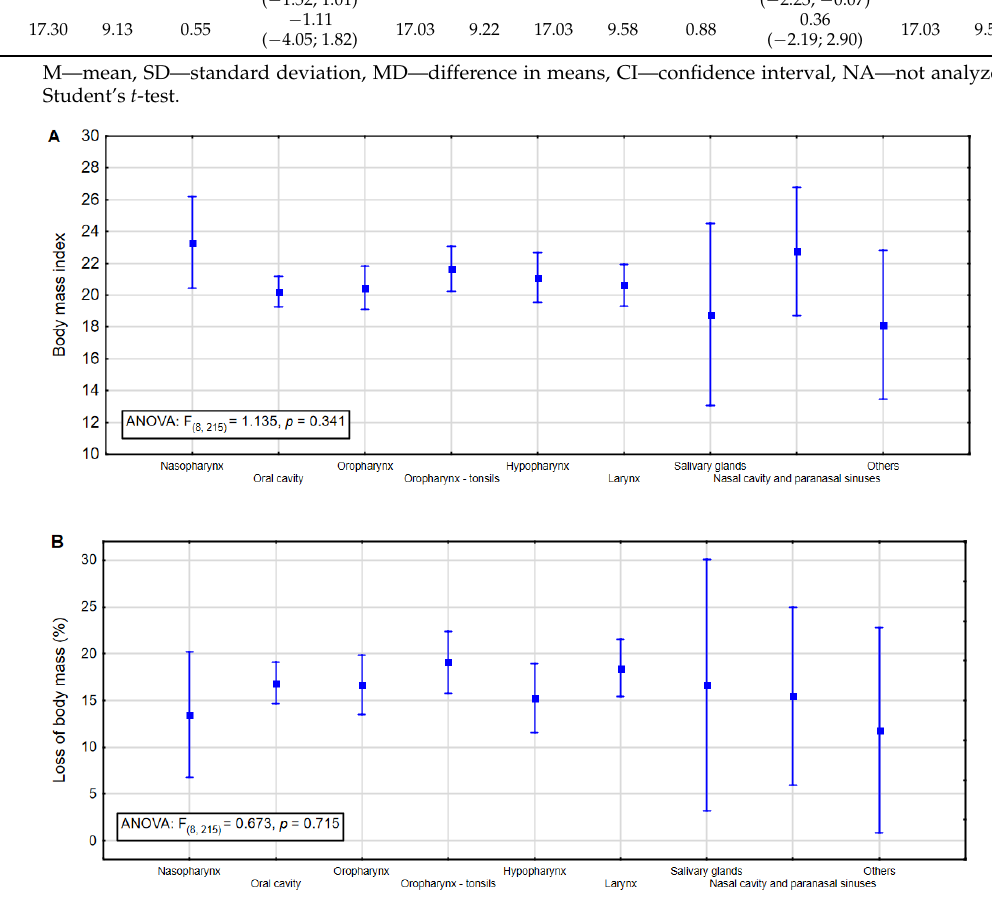
Figure 1. ( A ) Differences in mean of BMI divided into tumor site; ( B ) differences in mean of % of body weight loss in the last 6 months divided into tumor sites. The midpoint is the mean value, and the vertical line represents the 95% confidence interval.